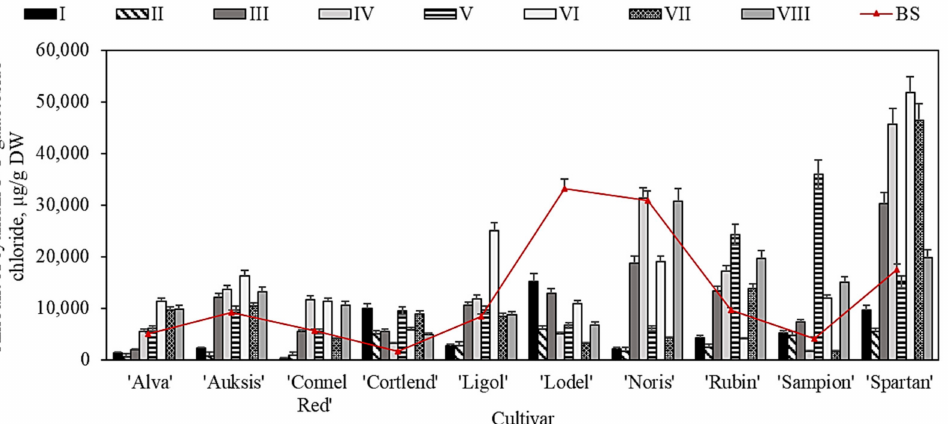
Figure 6. Changes in the cyanidin 3-O-galactoside chloride in the apple peel samples before and after storage in controlled